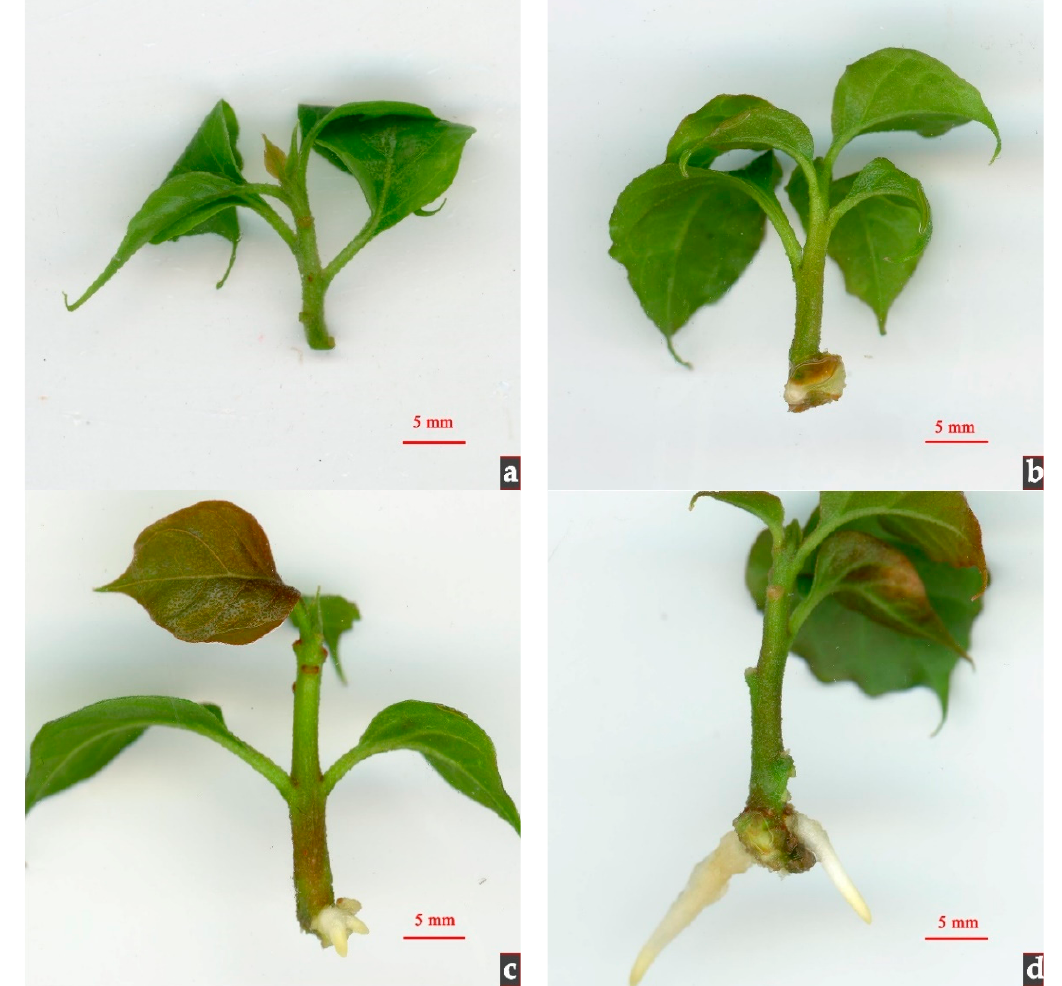
Figure 1. Morphological observation of the in vitro rooting of B. buttiana ‘Miss Manila’. ( a ) Morphological structure on Day 0. ( b ) Morphological structure on Day 7,14. The bottom of the bud kept expanding. ( c ) Morphological structure on Day 21 in tissue culture. The white root protruded from the bottom. ( d ) Morphological structure on Day 28 in tissue culture. Further elongation of adventitious roots.